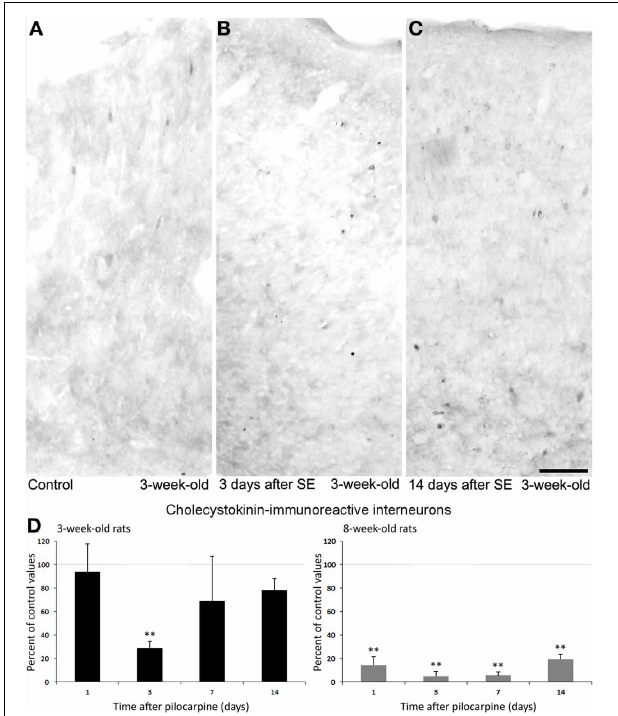
FIGURE 8 | Neuropeptide Y (NPY)-immunopositive interneurons in the rat perirhinal cortex. Photomicrographsshowing interneurons stained with an antibody against NPY in the perirhinal cortex of 3-week-old rats (A–C) . Specifically, NPY immunostaining is shown in a control, non-epileptic rat (A) and in pilocarpine-treated rats 3 (B) and 14 days (C) after pilocarpine treatment. (D) Normalized (respect to control) quantification of NPY immunostained neurons in 3 and 8-week-old rats following pilocarpine treatment. Note in the 3-week-old animals ( n = 3–6 for each time interval) that NPY immunostained neurons increased significantly 1 and 3 days after pilocarpine, but recovered 7 and 14 days later. Note that a consistent decrease in NPY interneurons was instead observed in 8-week-old rats ( n = 4–5 for each time interval). ∗∗ p < 0 . 01, analysis of variance followed by Tukey’s test for multiple comparisons. Scale bar: 100 μ m. Animal treatment is described in Biagini et al. (2008). Details of the immunostaining procedure and cell counts are as in Bortel et al. (2010); Benini et al. (2011) and Gualtieri et al.